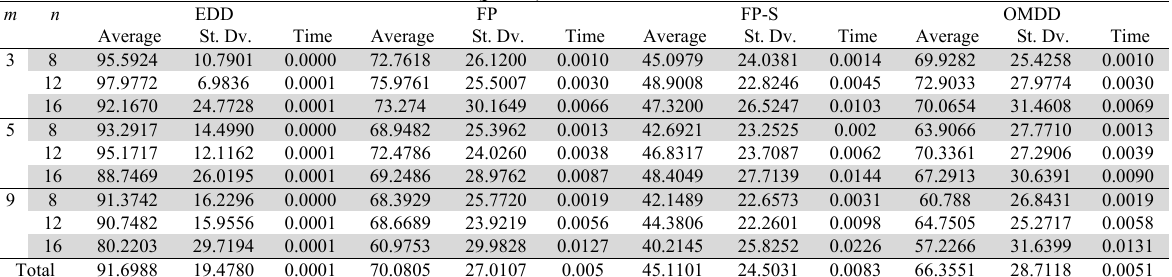
Small-sized test instances: RDI values for m and n (part 1) m